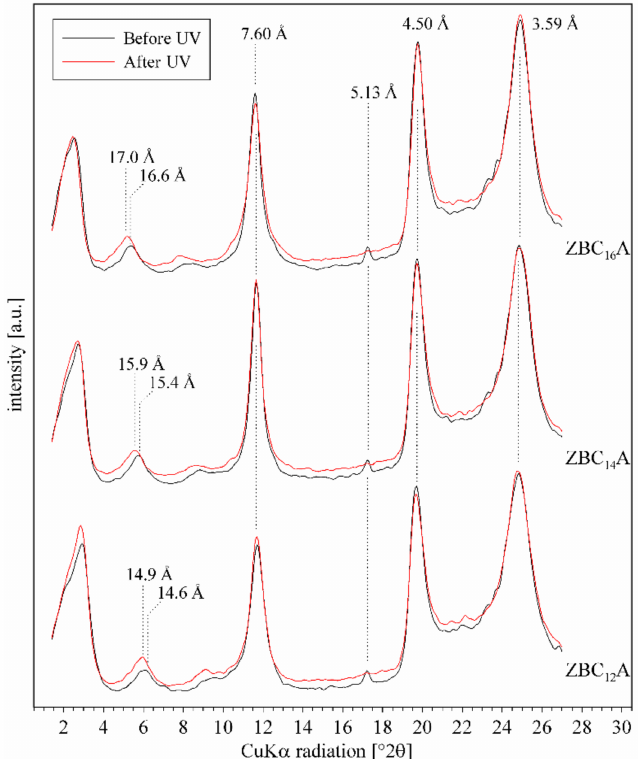
Figure 10. XRD patterns of ZBC n A samples before and after UV